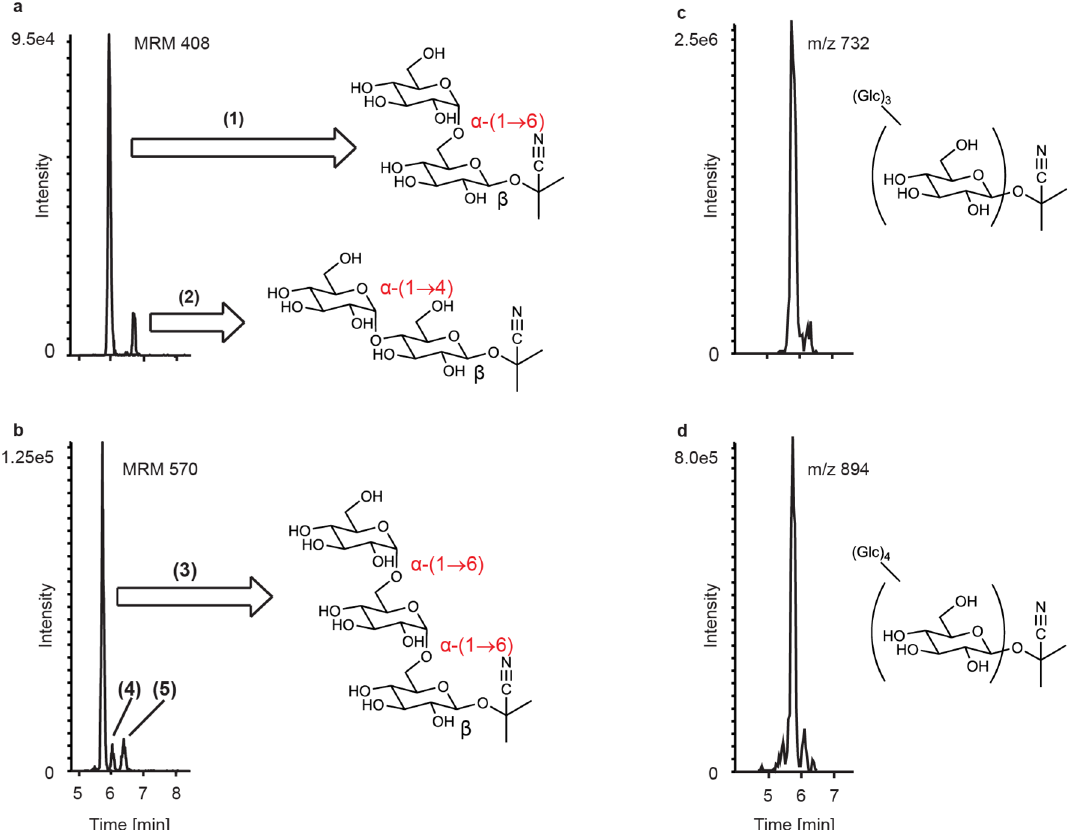
Figure 2. Novel linamarin-derived metabolites identified in B. tabaci honeydew. Linamarin-derived metabolites in the honeydew contain additional alpha-linked glucose moieties. ( a ) shows metabolites corresponding to 1 glucose addition (compounds ( 1 ) and ( 2 )) and ( b ) shows metabolite peaks corresponding to 2 glucose additions (compounds ( 3 ), ( 4 ) and ( 5 )). Metabolites with up to 4 further hexose additions were detected via untargeted analysis ( c and d ). Compounds ( 1 ), ( 2 ) and ( 3 ) were purified from honeydew and their structures determined by MS and NMR (Supplementary Note 1).